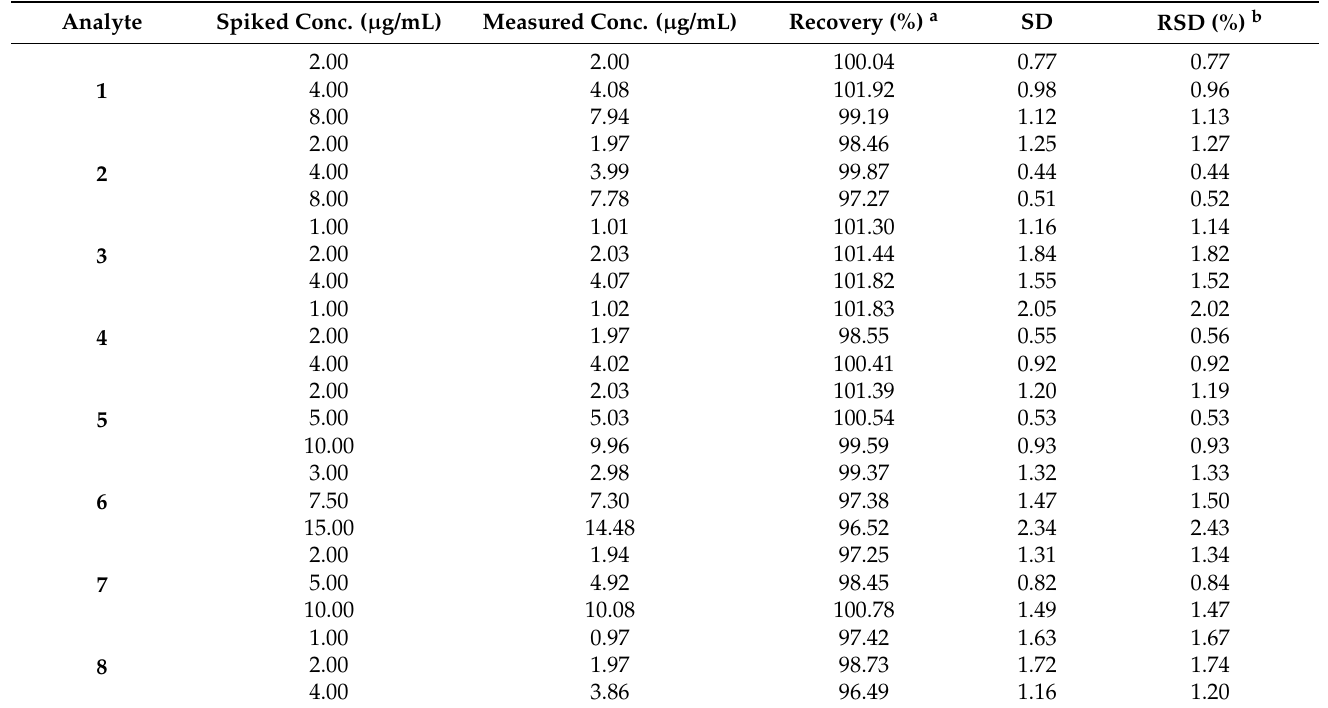
Table 2. Recovery (%) of 24 marker analytes in the developed analysis method ( n = 5).